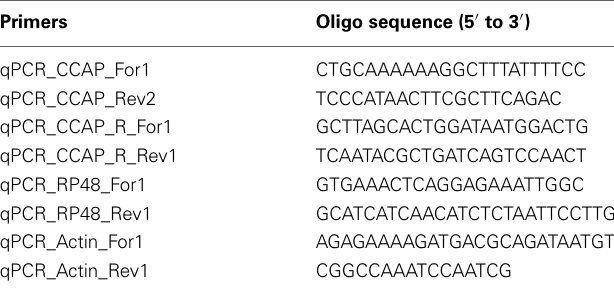
Table 1 | CCAP and its receptor primers in Rhodnius prolixus